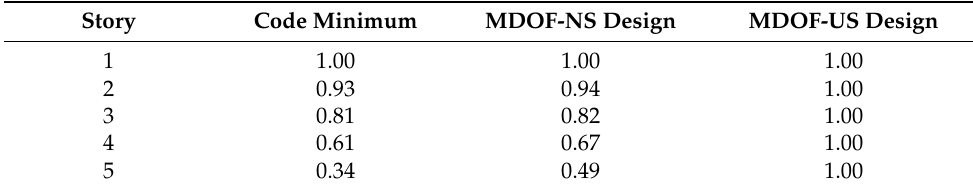
Table 3. Story shear to base shear